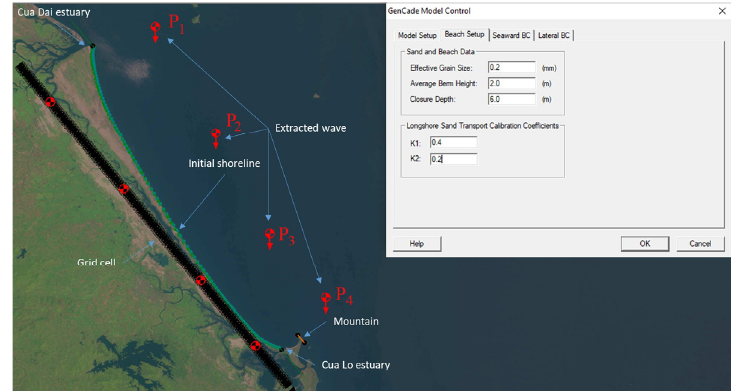
Figure 10. Establishment of the GenCade model from Cua Dai estuary to Cua Lo estuary.